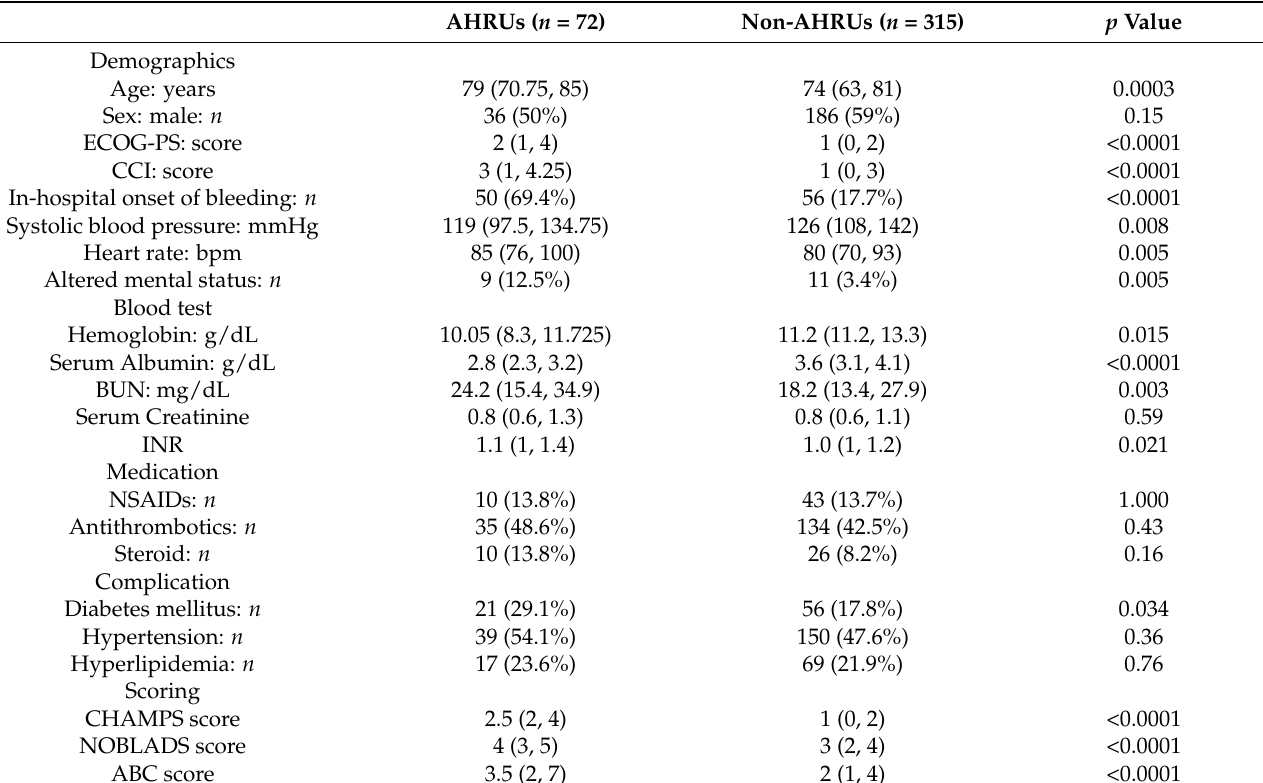
Table 1. Comparisons of clinical features between AHRU and non-AHRU lower gastrointesti- nal‘bleeding.